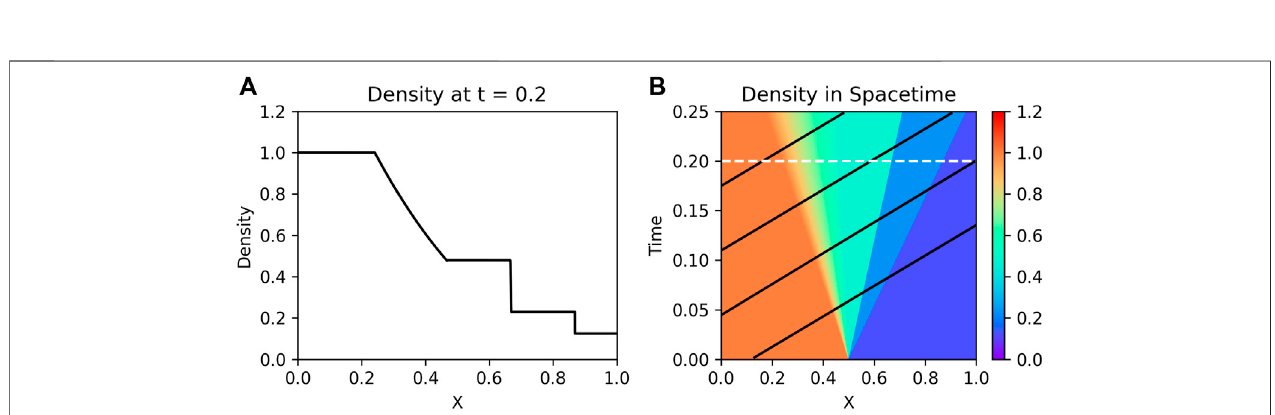
FIGURE 1 | Cartoon of PINN transformer architecture described in Eqs. 5 – 9 for an example two-layer network ( L (cid:1) 2), going left to right. The yellow boxes denote fully-connected linear layers with trainable tanh activation functions. The blue spheres denote elementwise operations ( ʘ and +) on their inputs.